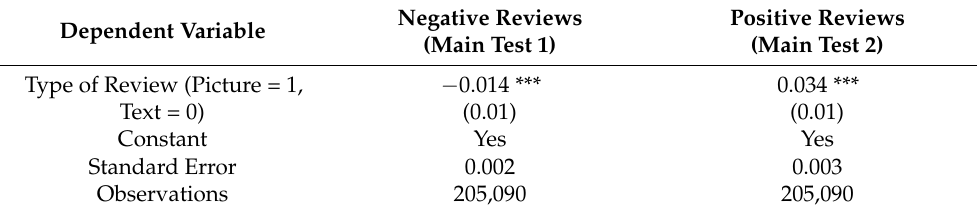
Table 10. Type of review—Review score 2.